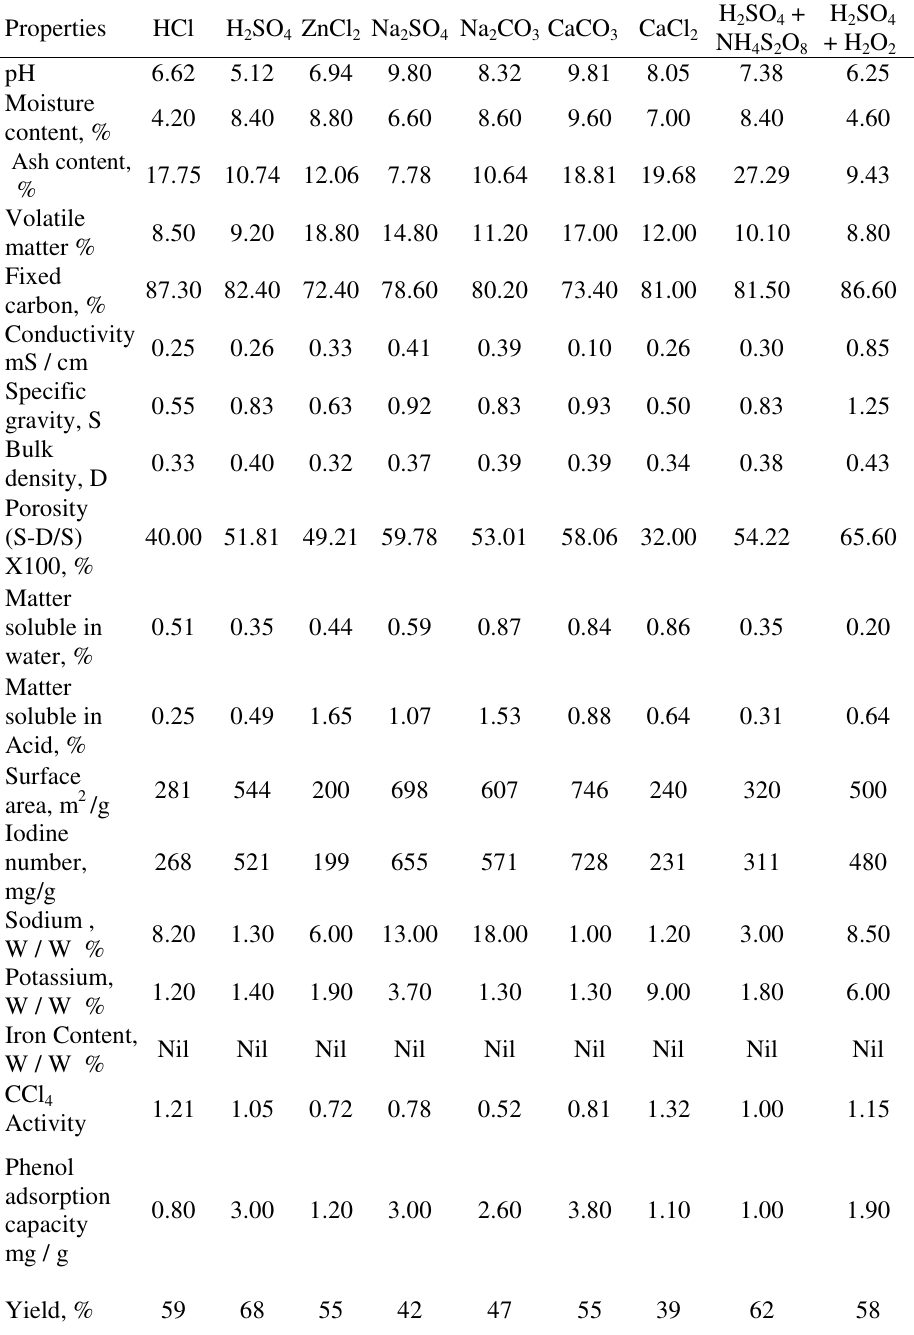
Table 5. Ipomea carnia stem waste activated carbon